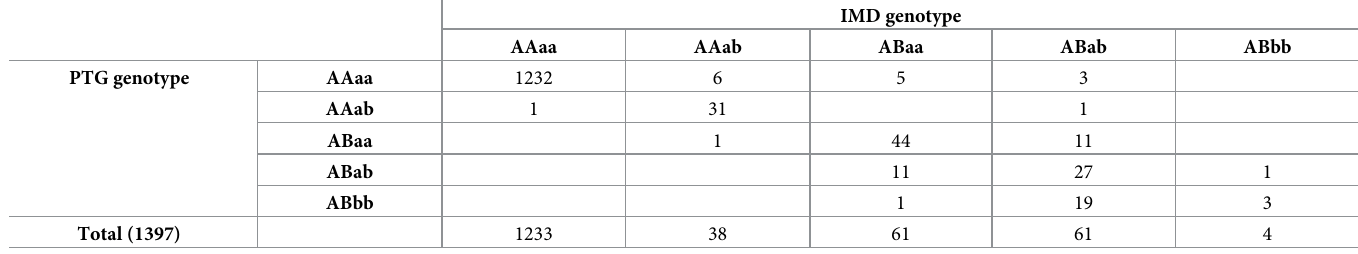
Table 3. Maternal-fetal genotype combinations concordance of the pseudo-tetraploid genotyping (PTG) with the gold standard invasive molecular diagnosis